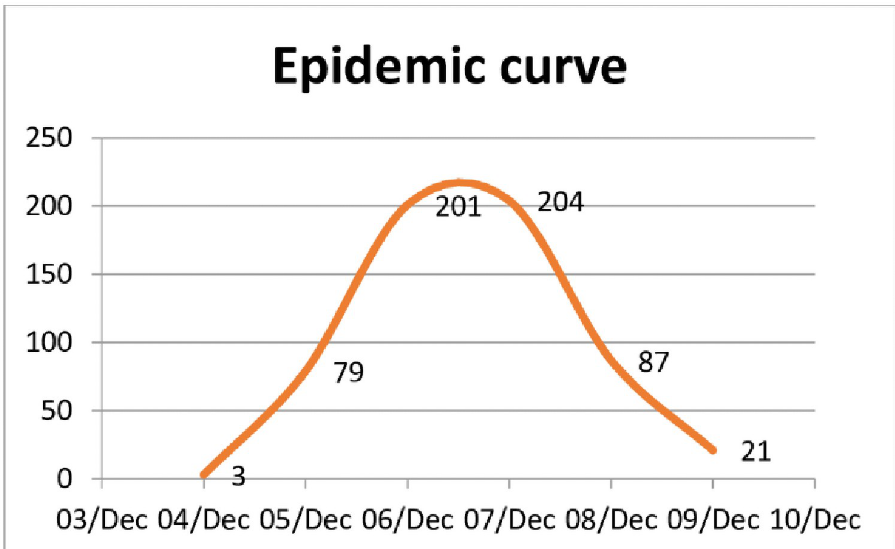
Fig 1. Epidemic curve of the reported cases during the